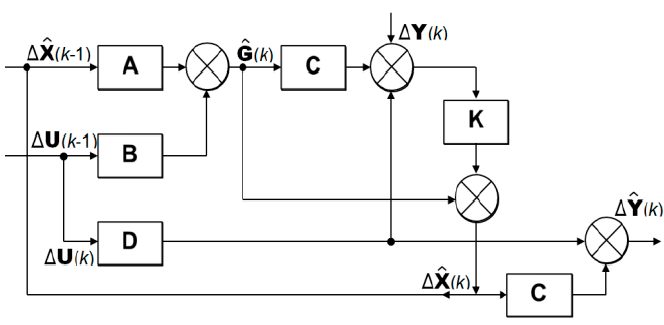
Figure 6. Filtered (reconstructed) GTE variables.